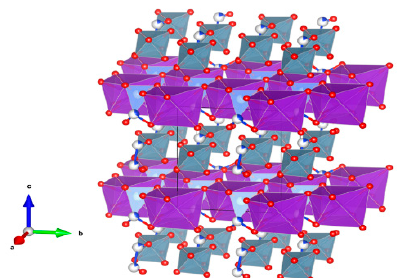
Figure 22. Micas (Dehydroxylated). XY 2–3 Z 4 O 10 (OH, F) 2 with X = K, Na, Ba, Ca, Cs, (H 3 O) and (NH 4 ); Y = Al, Mg, Fe 2+ , Li, Cr, Mn, V and Zn; and Z = Si, Al, Fe 3+ , Be and Ti. Structure monoclinic, Sp. gr. C2/c.